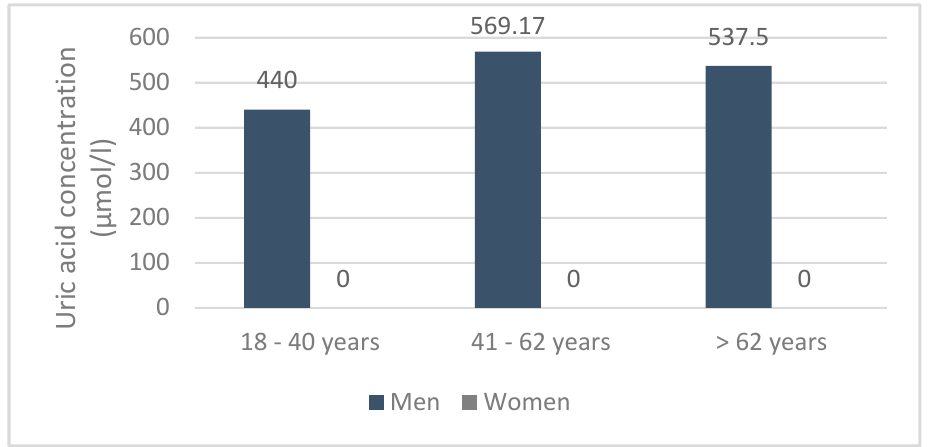
Figure 2. Serum uricemia in the gout population according to age and sex ( n = 12).